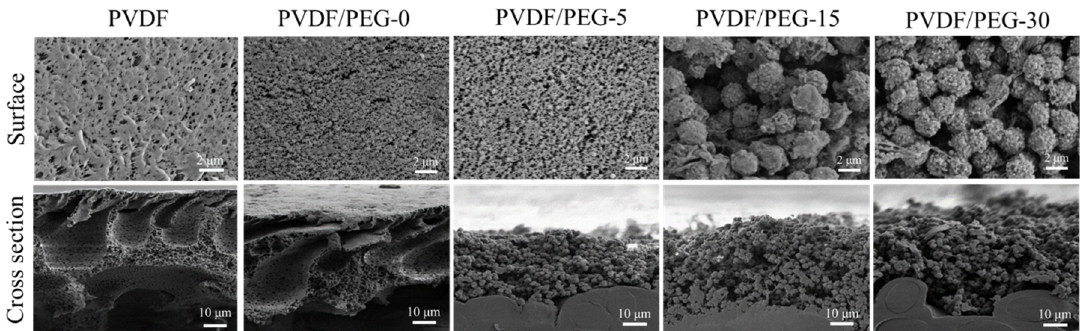
Figure 3. The FESEM images of the top surface and cross-sectional morphology of the resulting membranes at a magnification of 3000× and 1000×, respectively.